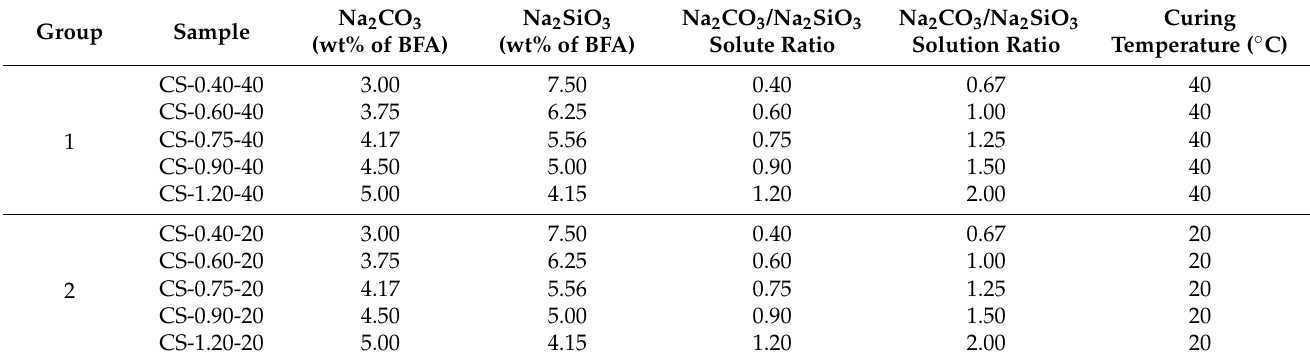
Table 2. Composition of BFA-based AAM pastes (Group 1 and 2).